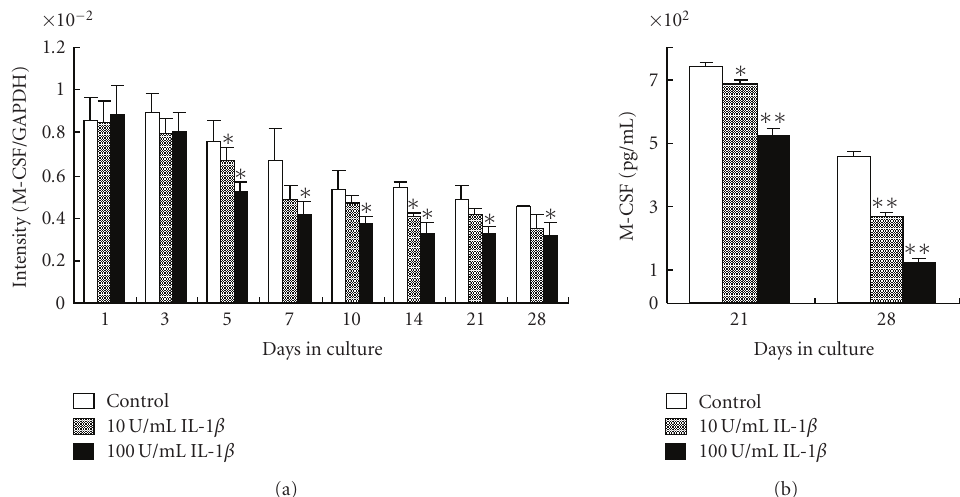
Figure 2: E ff ect of IL-1 β on M-CSF gene and protein expression. (a) Cells were cultured with 0, 10, or 100U/mL IL-1 β and M-CSF gene expression was determined by real-time PCR on days 1, 3, 5, 7, 10, 14, 21, and 28 of culture. (b) M-CSF protein expression determined by ELISA on days 21 and 28. Each bar indicates the mean ± SD from four separate experiments. ∗ P < . 05, ∗∗ P < . 01 for IL-1 β treatment versus the control.